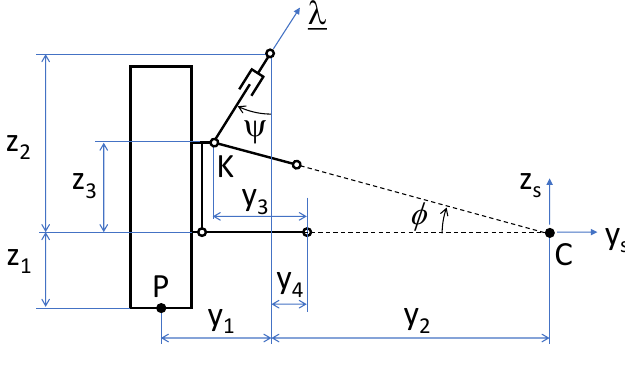
Figure 10. Double wishbone